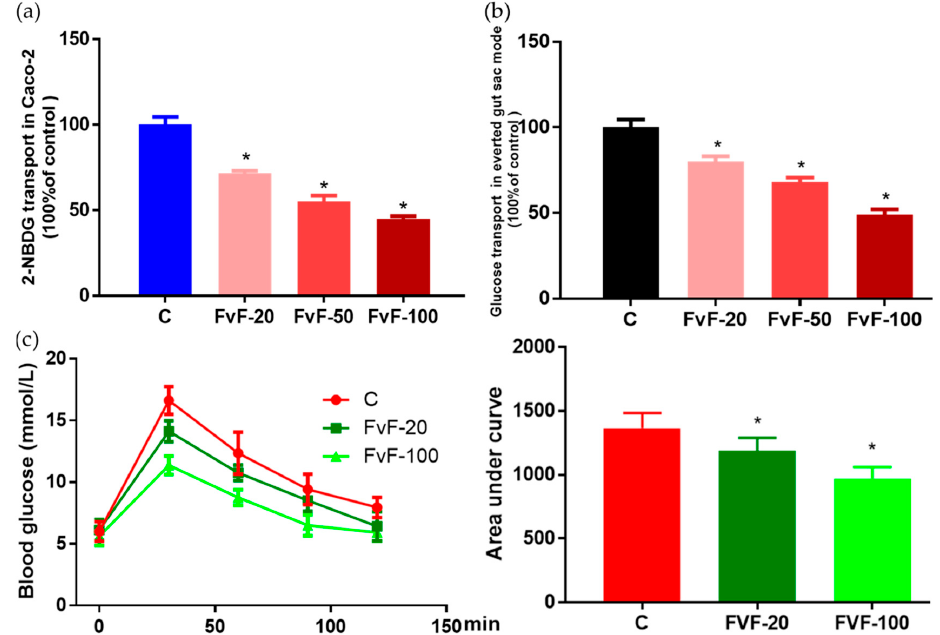
Figure 7. Effects of fucoidan from Fucus vesiculosus (FvF) on on glucose transport. FvF on the 2-( N -(7-nitrobenz-2-oxa-1,3-diazol-4-yl)amino)-2-deoxyglucose (2-NBDG) transport in Caco-2 monolayer model ( a ) and glucose transport in everted gut sac model ( b ). Caco-2 monolayer model and everted gut sac model were treated with 0, 20, 50, or 100 μ g/mL of FvF. Oral glucose tolerance test (OGTT) was conducted with eight-week-old male kunming mice ( c ). Mice were perfused with 20 or 100 mg/kg of FvF 30 min before oral glucose administion (2 g/kg body weight). Data are expressed as the mean ± SEM. Differences were assessed by ANOVAs and statistical results are denoted as follows: * p < 0.05 versus the control group; # p < 0.05 versus the model group.